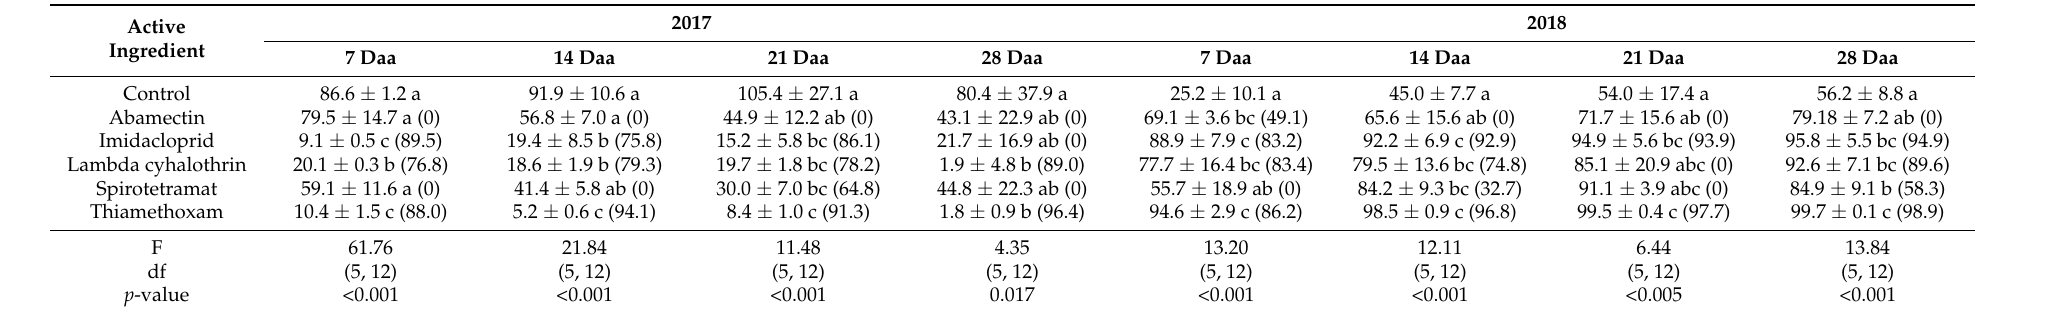
Table 6. Effect of insecticides on T. erytreae expressed as the mean of live nymphs per shoot (mean ± standard error) at different times (7, 14, 21, and 28 days after application (daa)) in 2017 and 2018 spring trial. In brackets, the percentage means of corrected mortality